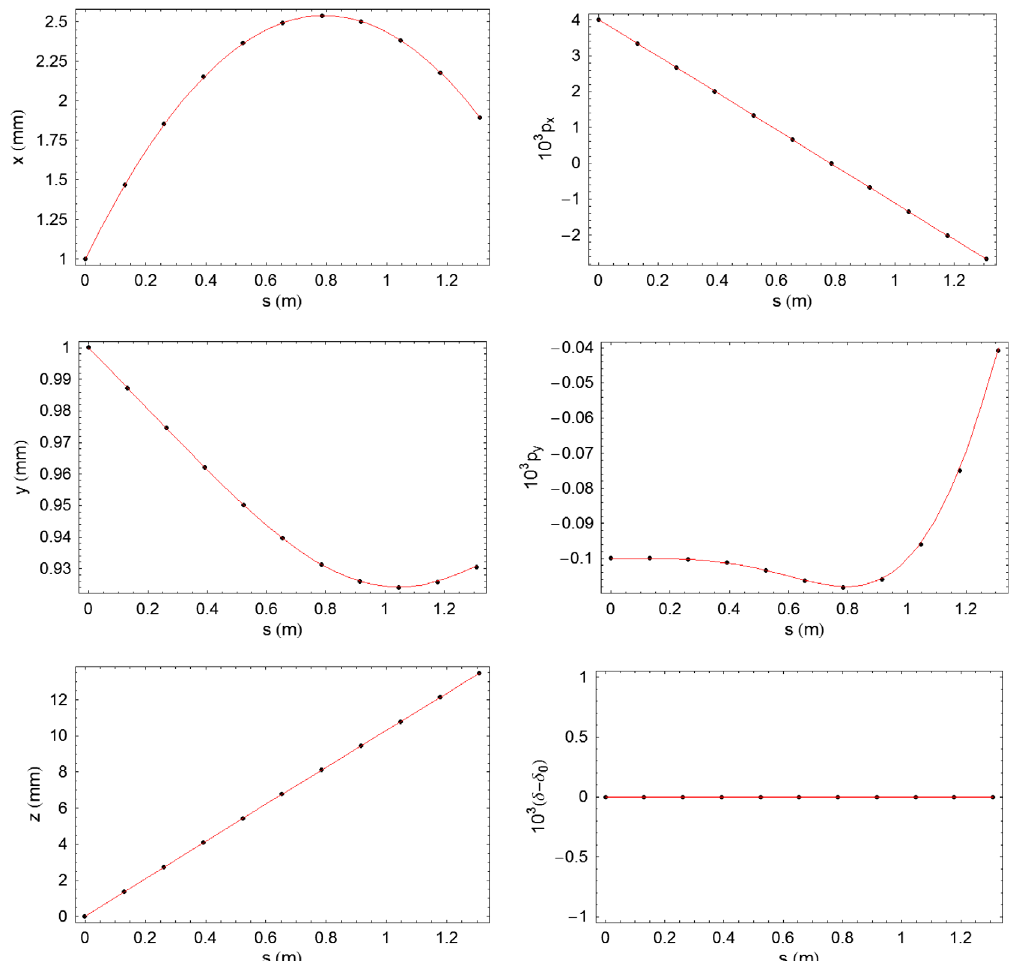
).FIG. 5. Results of tracking a particle through a magnetic curvilinear skew sextupole, described by the magnetic scalar potential given in Eq. (92). The black points show the results from the explicit symplectic integrator presented in Sec. III. The red lines show the results of numerical integration of the equations of motion derived from the Hamiltonian